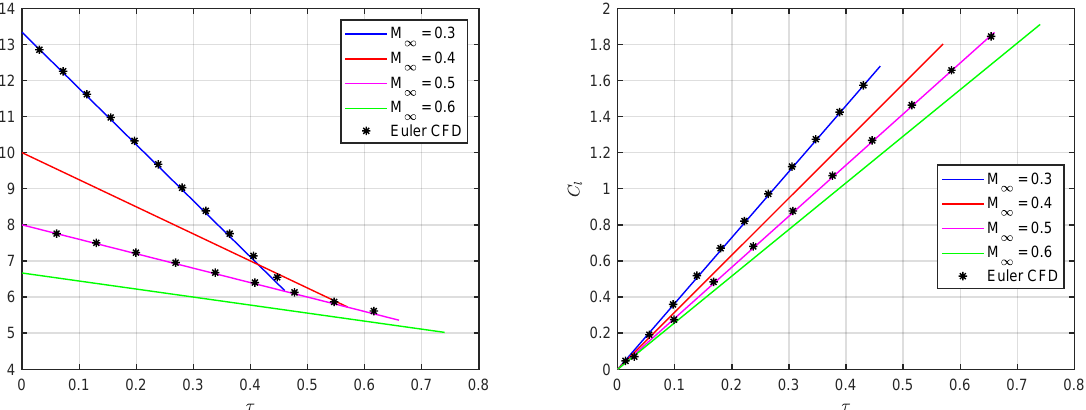
Figure 6. The Mach effect on the incipient indicial lift for thin aerofoil in compressible flow: AOA ( left ) and SEG ( right ), with Λ = 0 ◦